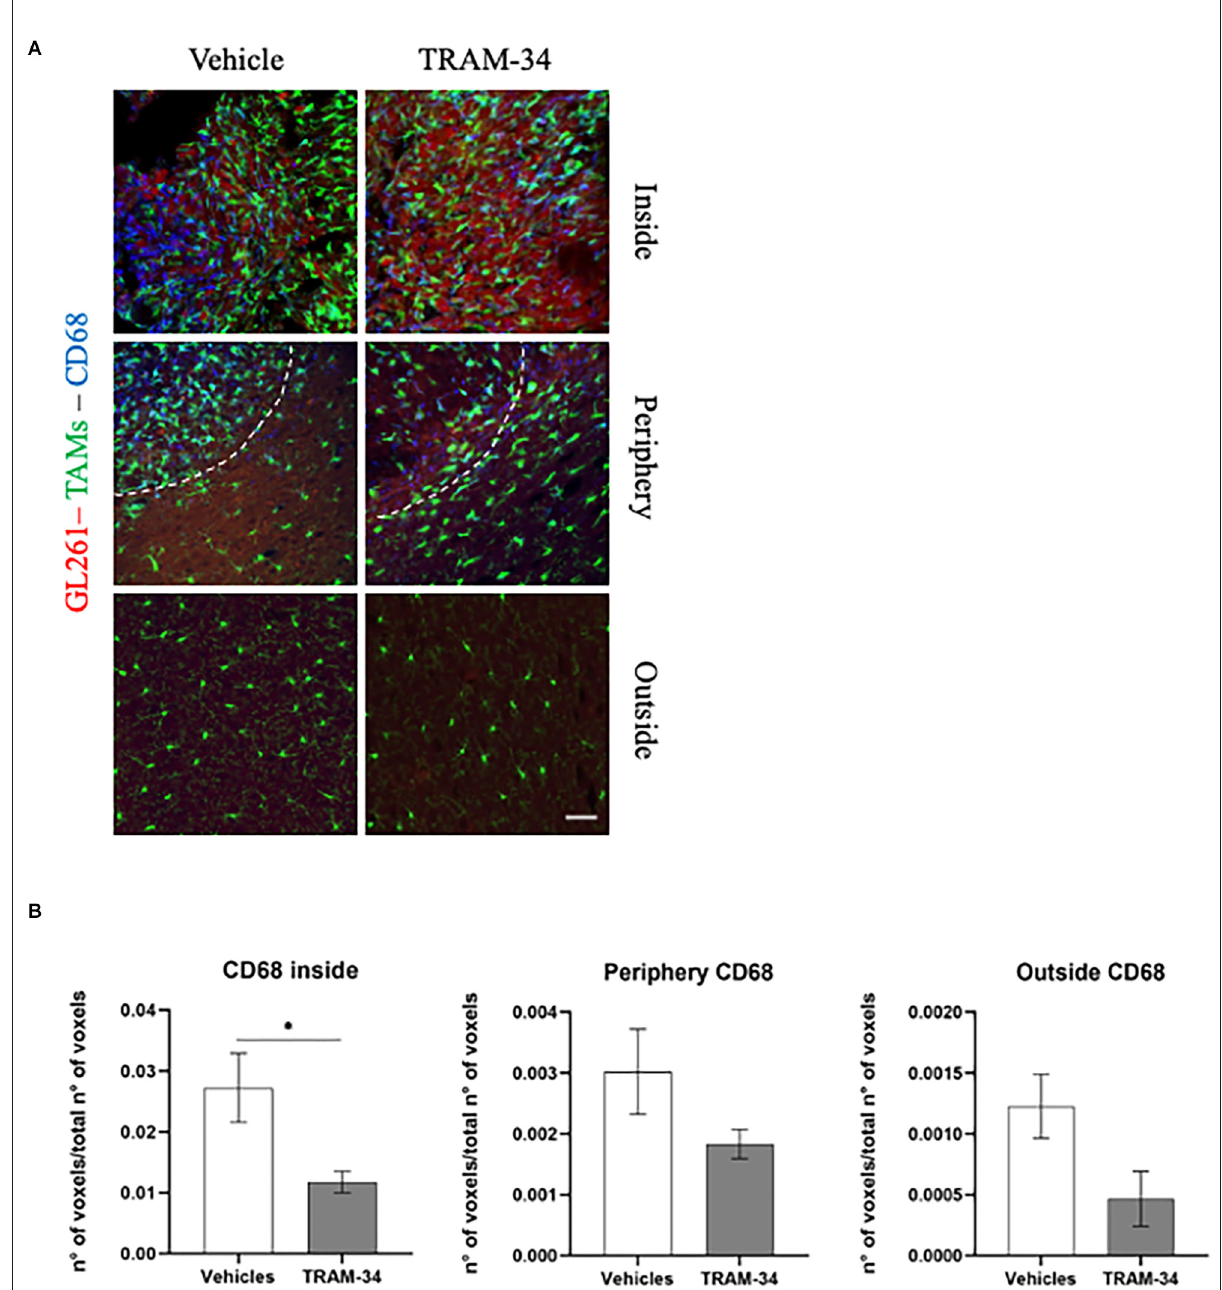
FIGURE4 Immunofluorescence analysis of phagocytic marker CD68. (A) Representative confocal images at 40 × magnification of the tumor of CX3CR1 mice, stained with anti-CD68 antibody (blue), at T2. Scale bar = 30 µ m. (B) Number of CD68-positive voxels over the total number of voxels per ROIs inside, peripherical and outside the tumor of vehicles and TRAM-34 groups ( n = 4/group). Analysis with unpaired t-test; mean ± SEM, ∗ p <